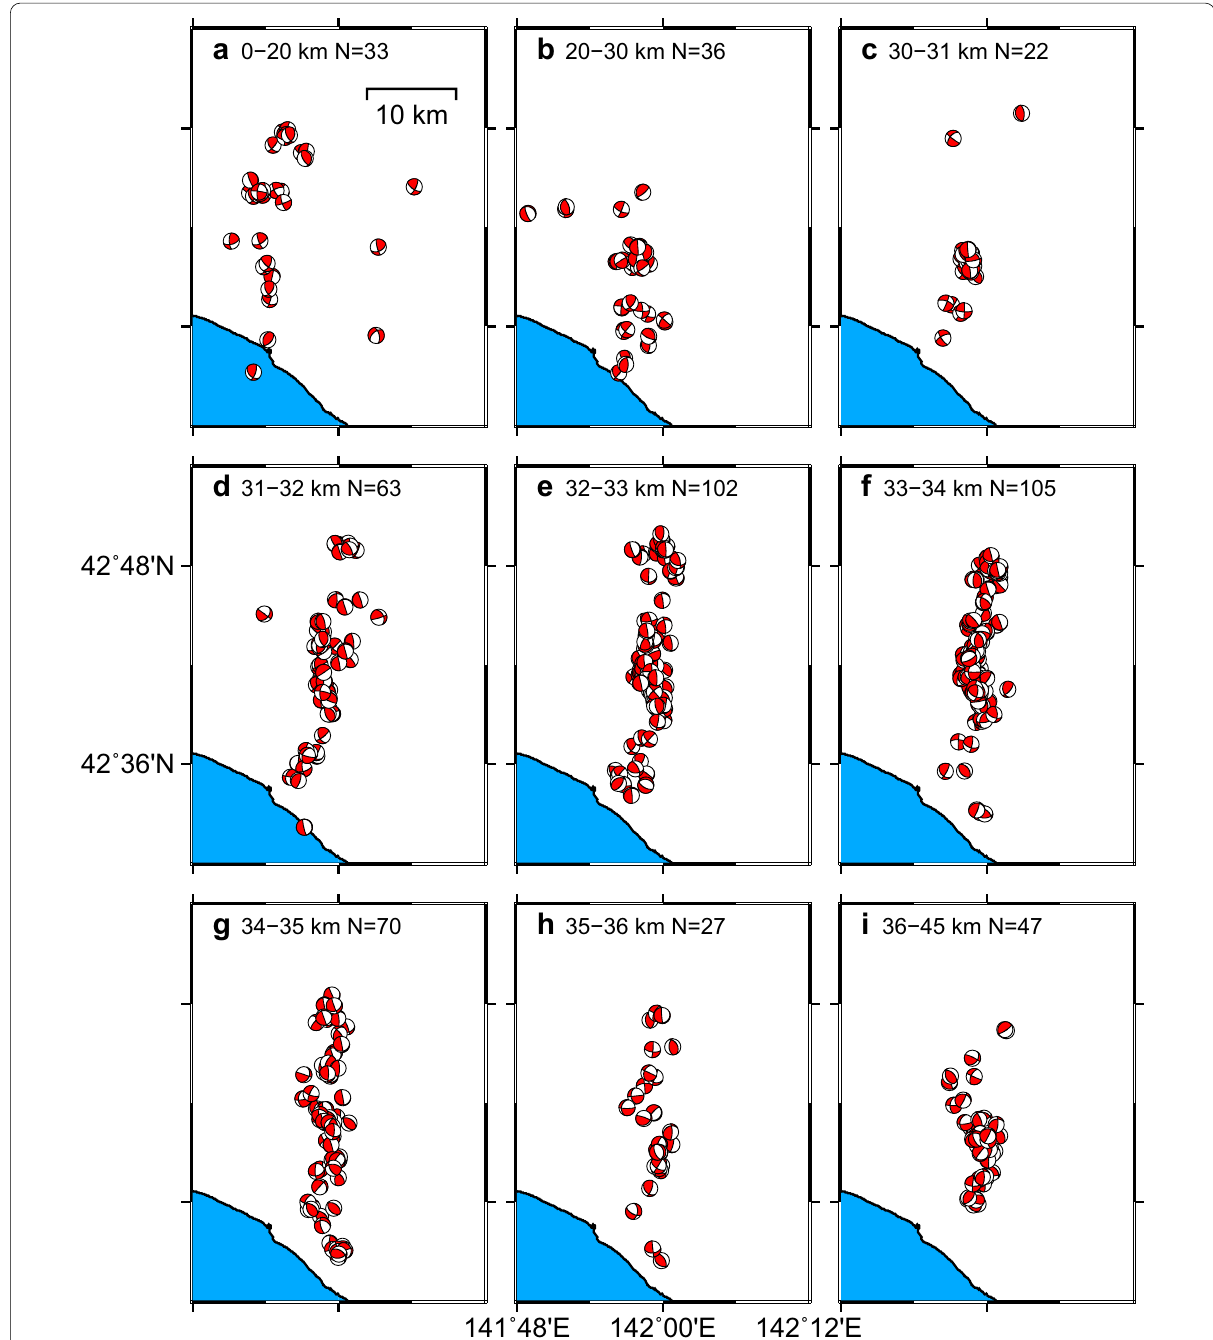
Fig. 4 Focal mechanism solutions with Quality A and B determined in this study. The depth of hypocenter is a 0–20 km, b 20–30 km, c 3 0 –31 km, d 31–32 km, e 32–33 km, f 33–34 km, g 34–35 km, h 35–36 km, and i 36–45 km. All diagrams are equal area projections on the lower hemisphere of the focal sphere. Colored areas show compressional